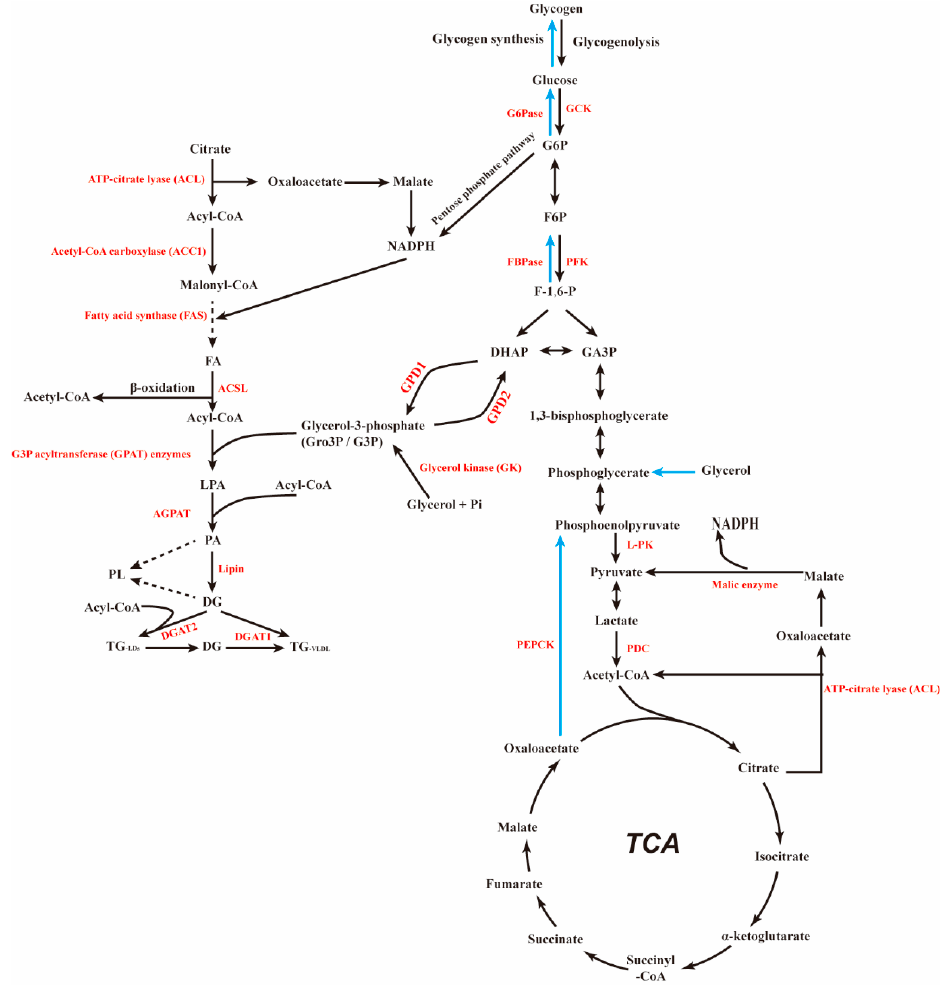
Figure 1. The enrichment of glucose-induced glucokinase (GCK), which phosphorylated glucose to glucose-6-phosphate (G-6-P); it is used as a substrate for glycolysis or glycogen synthesis, depending on the nutritional status. The product pyruvate is further decarboxylated to acetyl coenzyme A and enters the tricarboxylic acid cycle (TCA) in mitochondria. Acetyl coenzyme A or malonyl coenzyme A synthesize fatty acids from scratch and further process them into TAG. In mammals, FA synthesis is catalyzed by acetyl CoA carboxylase (ACC) and fatty acid synthase